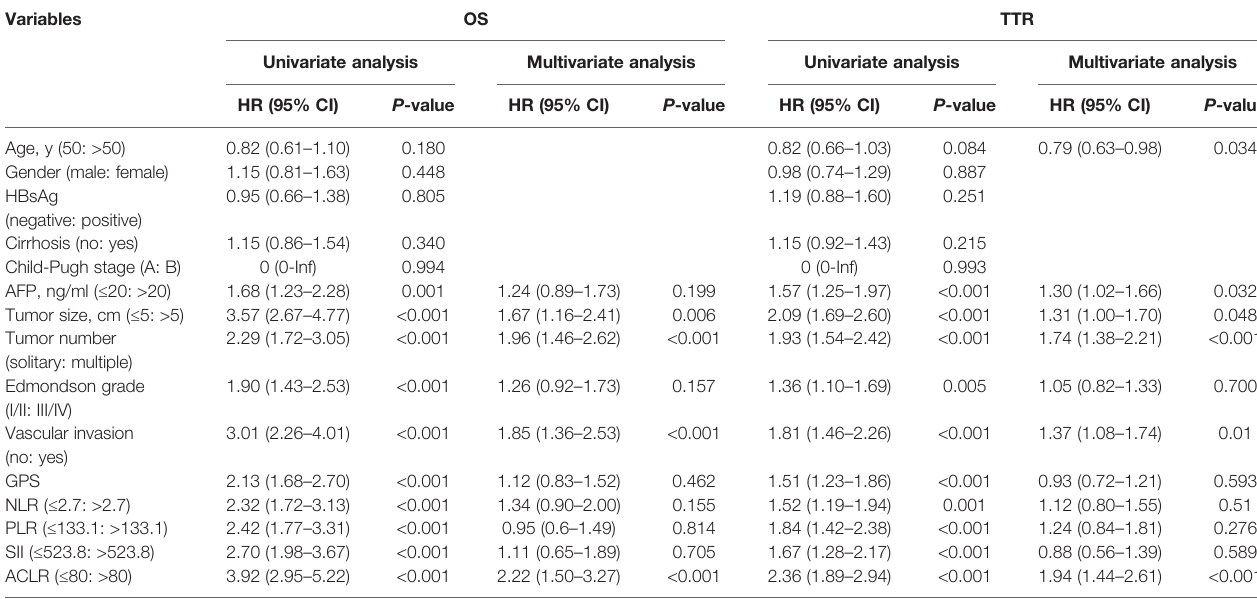
TABLE 2 | Univariate and multivariate analyses in the training cohort. Variables OS